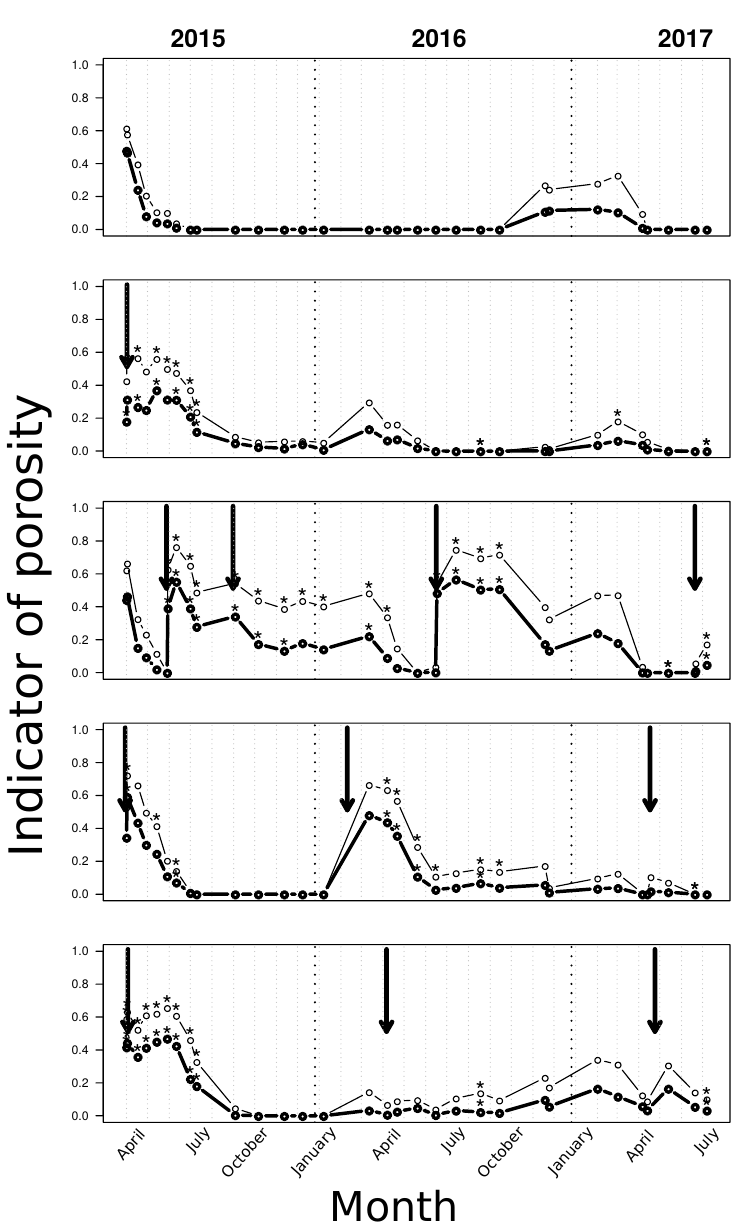
Figure 8. Evolution of the two indicators PORO section (thick line) and PORO surface (fine line) against time and across different treatments presented from top to bottom: control, dredged, mowed, burned, and chemically weeded. The dots correspond to the value averaged over the four replicates, and the standard deviations were not represented for readability. The two indicators were estimated for a virtual water level of 0.5 m. Black arrows indicate the timing of the practice. The star symbol * indicated that treatment was significantly different from control at p < 0.05 (based on Tukey’s